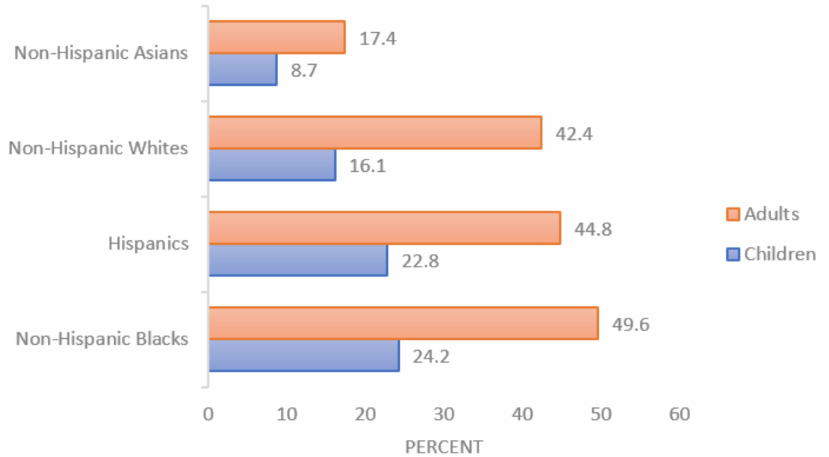
Figure 1. Prevalence of obesity among children and adults, by race and ethnicity in the United States; adapted from 2017–2018 NHANES data